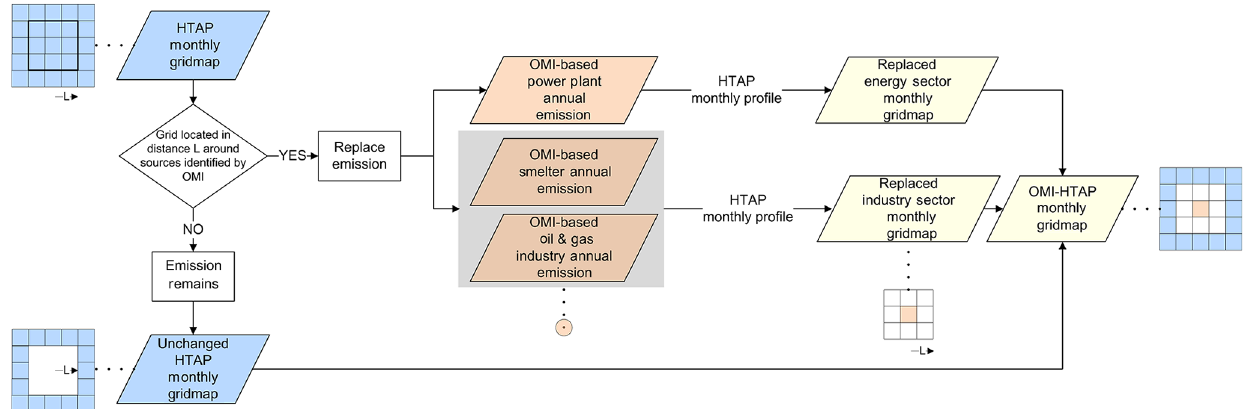
Figure 1. Schematic methodology of the OMI-HTAP emission inventory development.